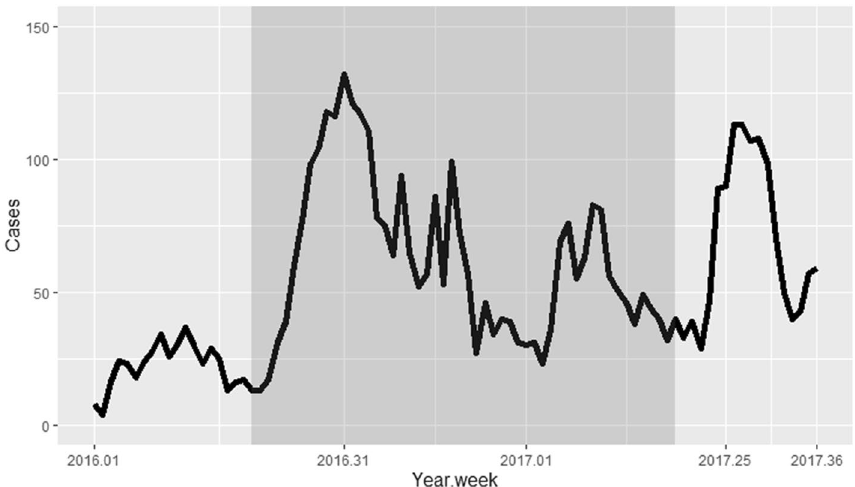
Figure 2. Time series of the number of malaria cases collected through passive case detection. The shaded (dark) area represents the epidemic year considered for analysis.